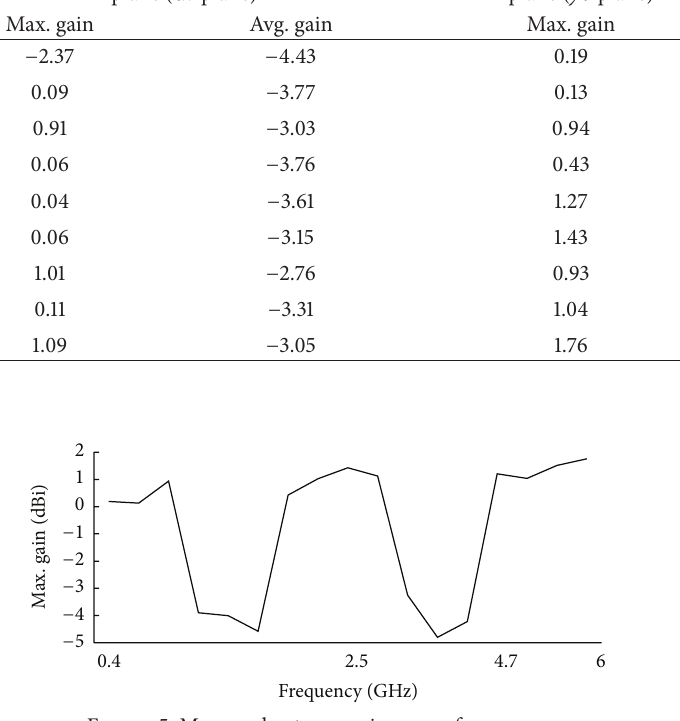
Figure 5: Measured antenna gain versus